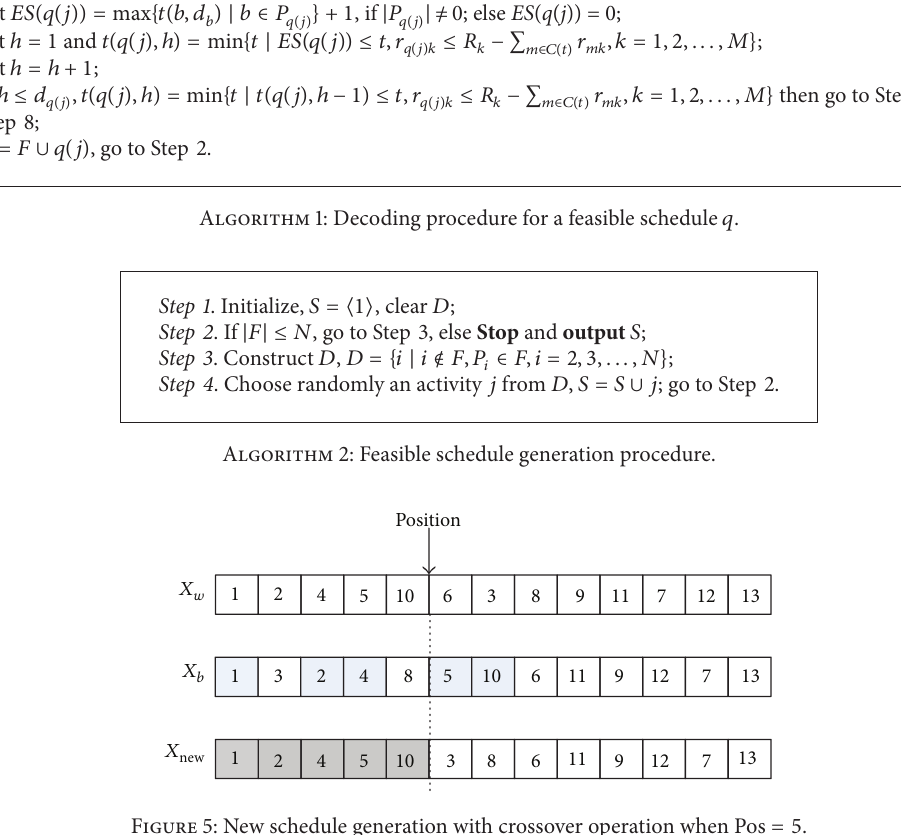
Figure 5: New schedule generation with crossover operation when Pos = 5 .